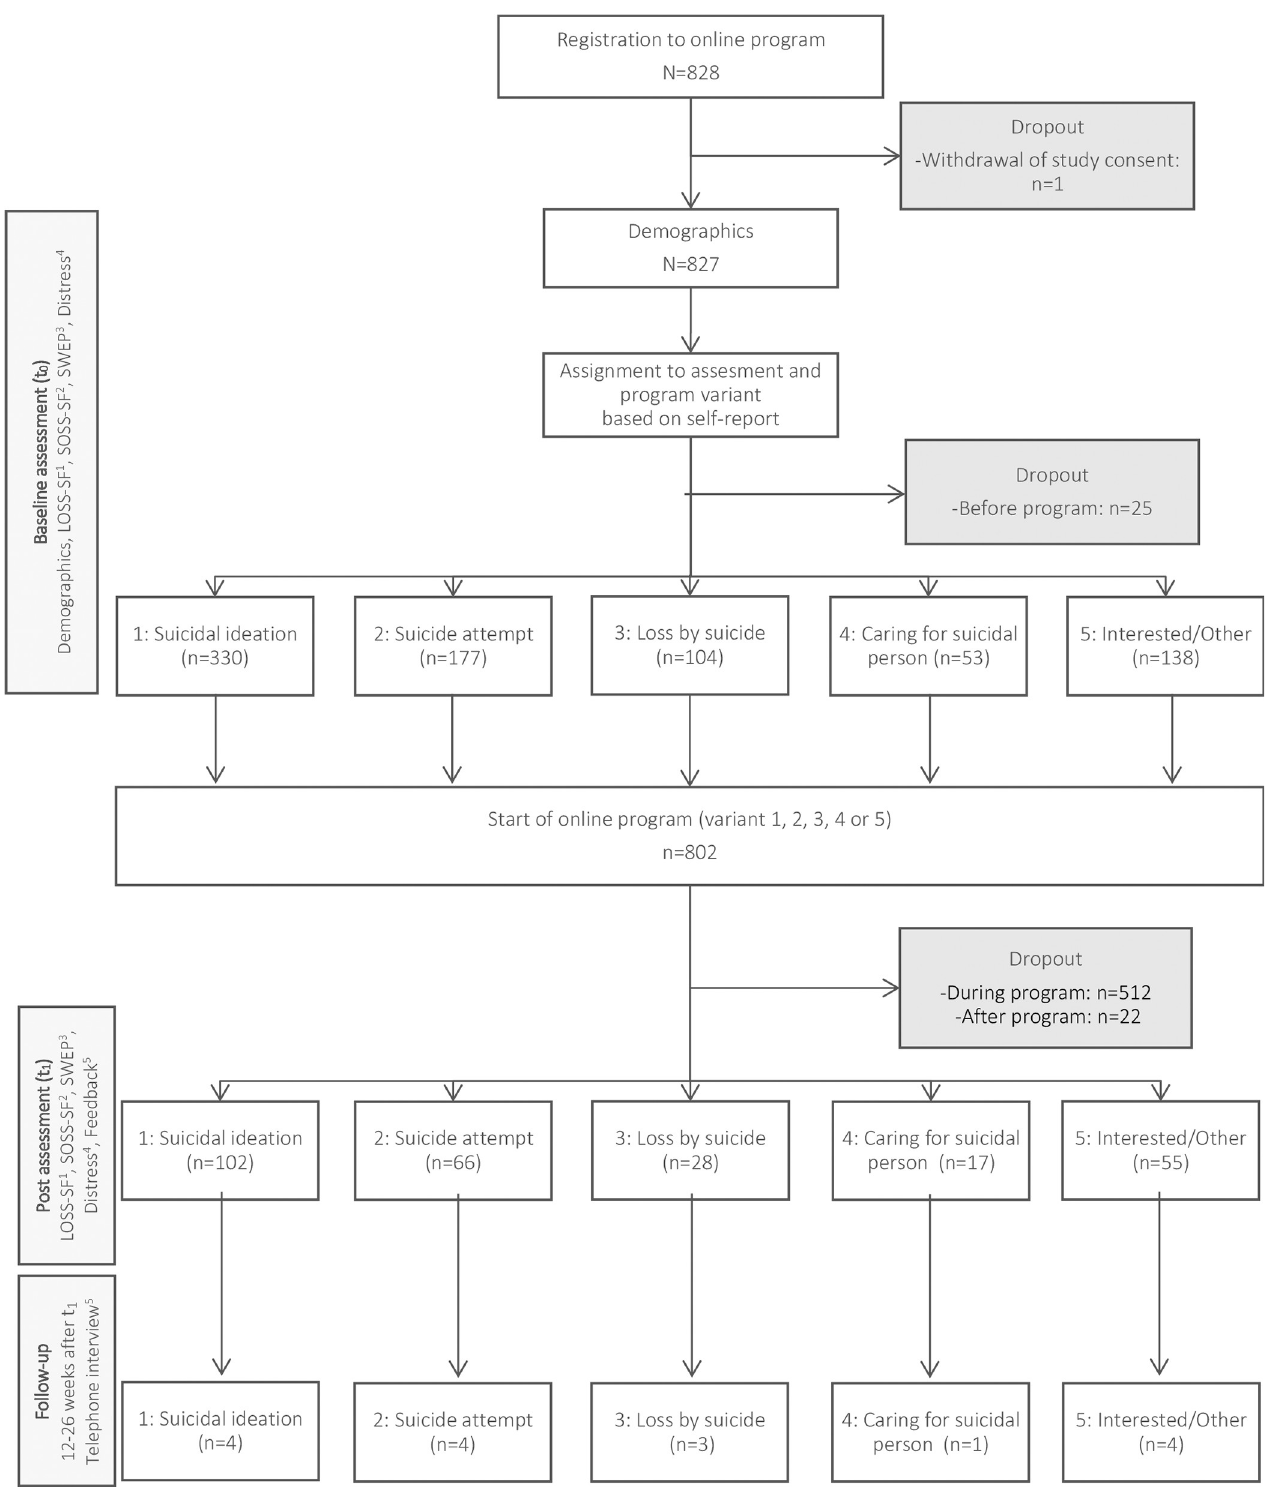
Fig 1. Flow chart. 1 LOSS-SF: Literacy of Suicide Scale, 2 SOSS-SF: Stigma of Suicide Scale 3 SWEP: Self-efficacy expectations of being able to seek support in psychologically difficult situations, 4 Distress thermometer, 5 Self-developed instrument.